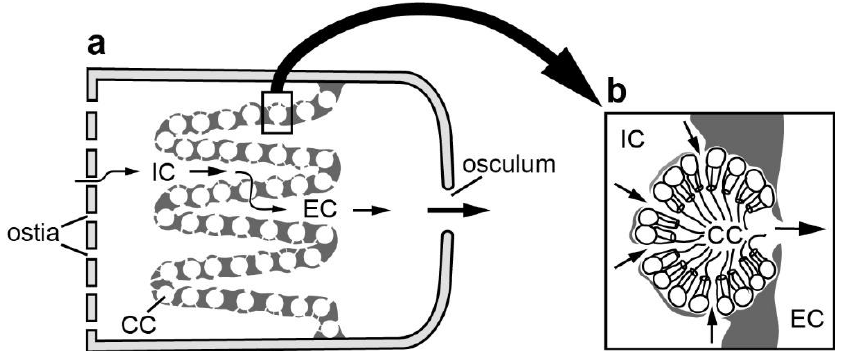
Figure 1. Sketch of a single-osculum demosponge showing the water flow from outside through ostia into inhalant canals (ICs) to the water pumping choanocyte chambers (CCs), where the water is filtered, then further into exhalant canals (ECs) and subsequently out through the osculum. The thin wall separating the tapered inhalant and exhalant canals is for a great part made up of CCs embedded in the mesenchyme. Adapted from [9].